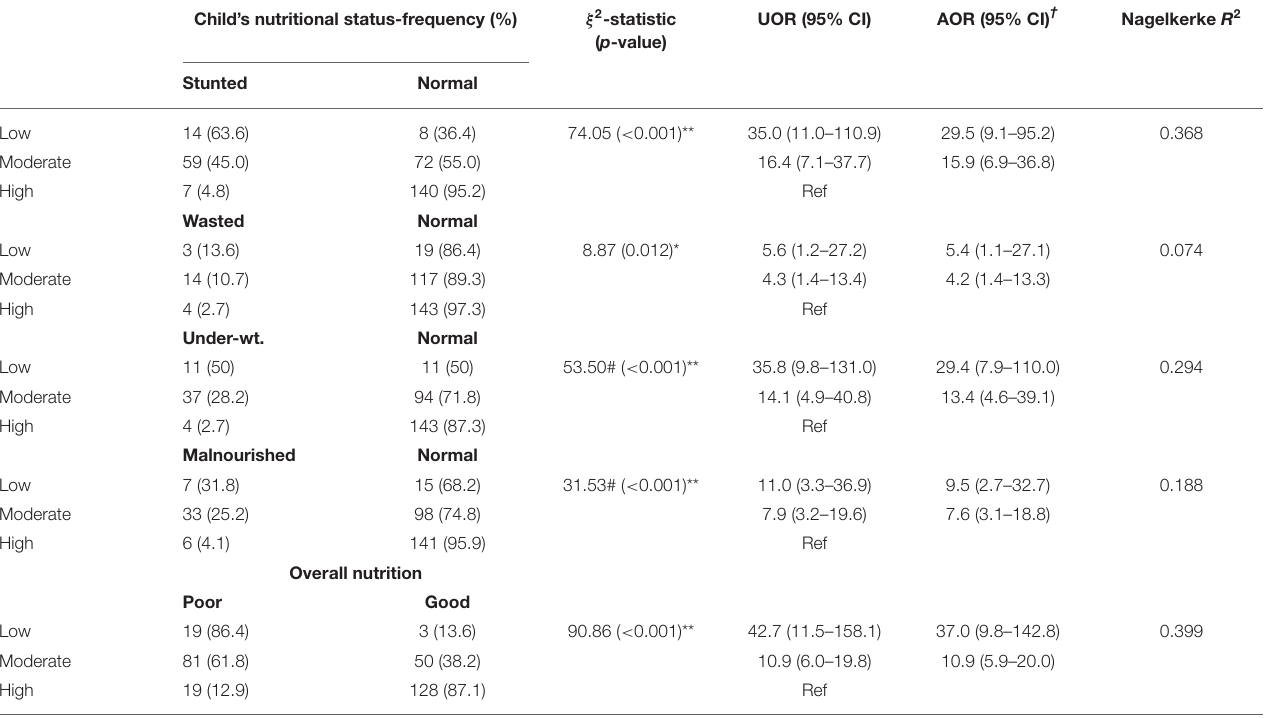
TABLE 4 | Strength of association between maternal empowerment and children’s nutrition. Child’s nutritional status-frequency